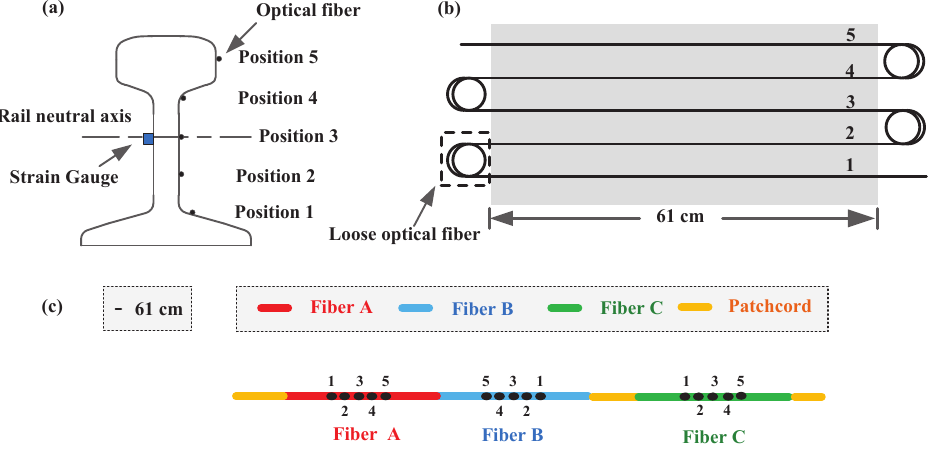
Figure 2. ( a ) Cross section of the rail specimen; ( b ) layout of a certain type of fiber (Fiber A, Fiber B, or Fiber C) glued on the surface of the rail specimen with a length of 61 cm; ( c ) overall connection diagram of three types of sensing fiber along the rail